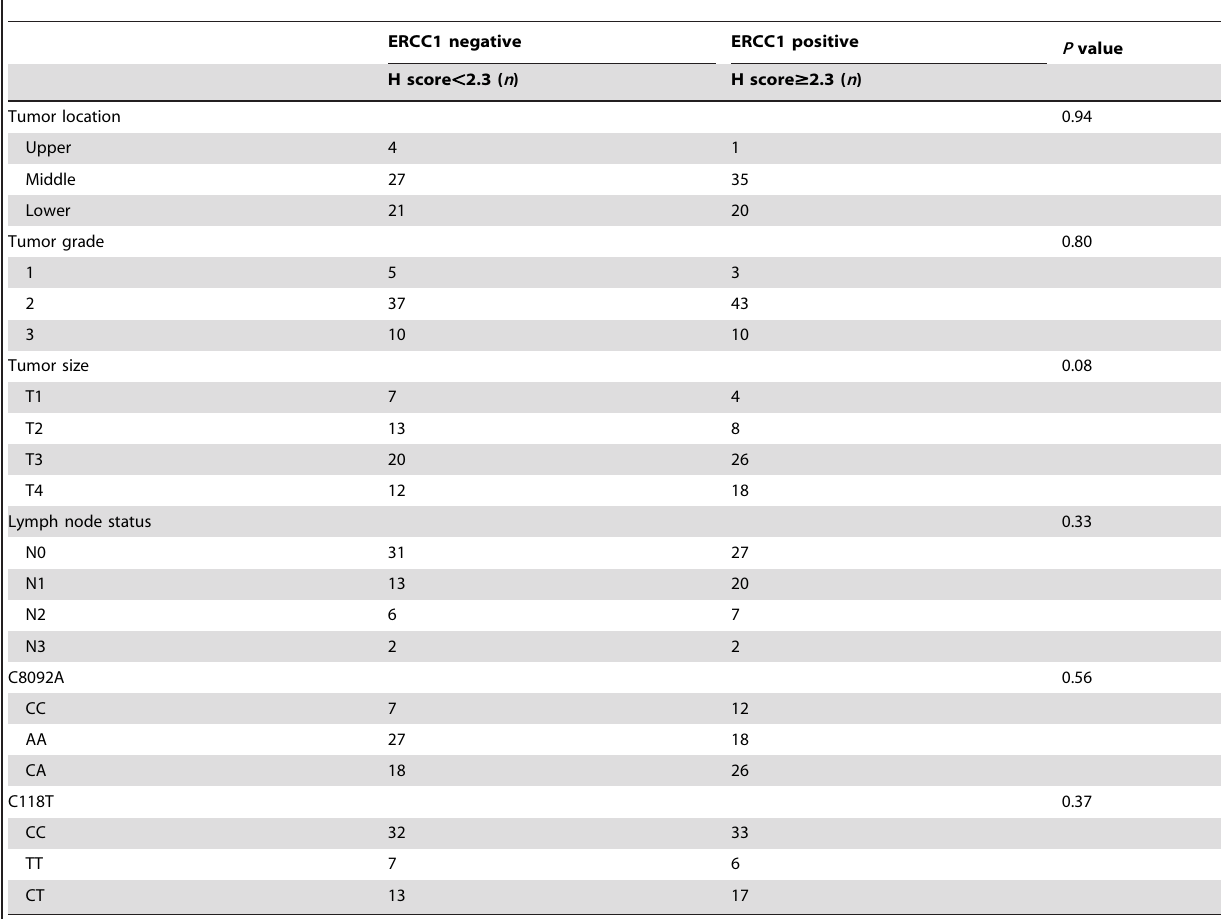
Table 2. Clinicopathological patient characteristics according to ERCC1